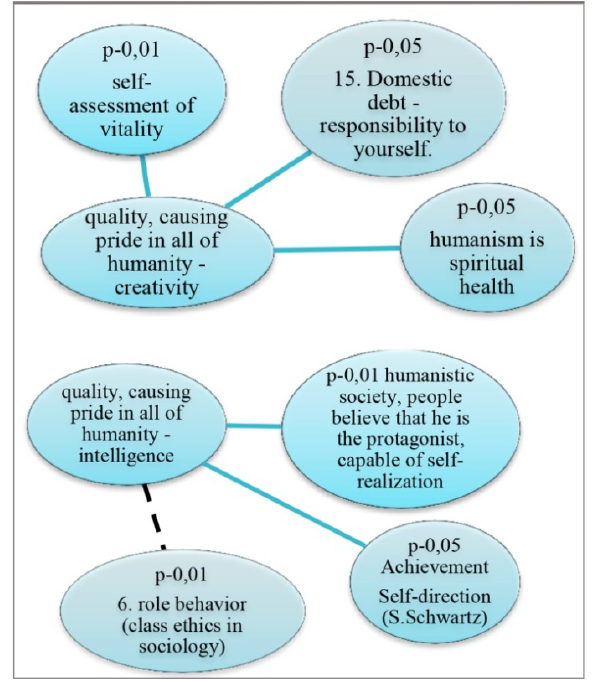
Fig. 5. Correlations with the opinion "creativity causes pride in humanity".